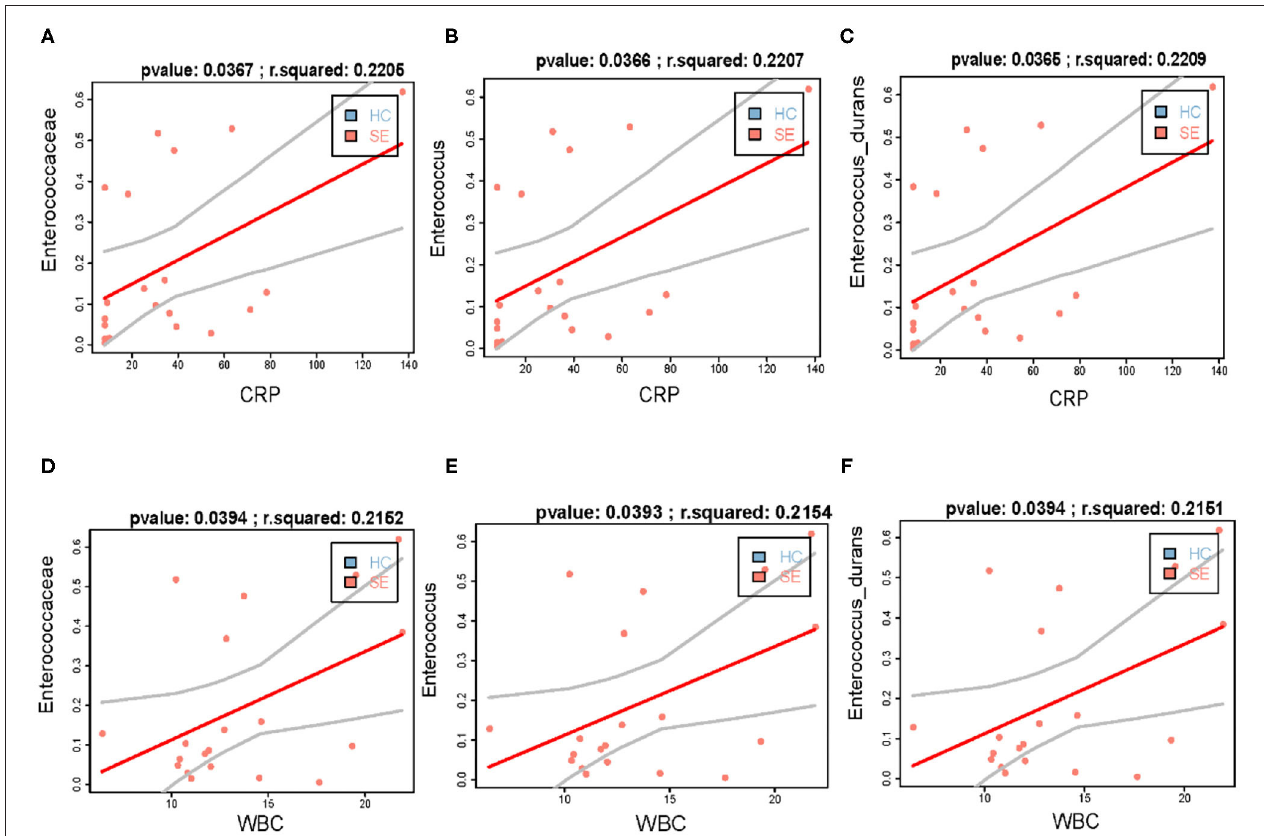
FIGURE 2 | The increase in the abundance of Enterococcaceae bacteria in gut of patients with sepsis is positively correlated with the increase in blood indicators WBC and CRP. (A–C) the increased abundance of gut Enterococcaceae (A) , Enterococcus (B) , and Enterococcus durans (C) is positively correlated with WBC, respectively; (D–F) the increased abundance of gut Enterococcaceae (D) , Enterococcus (E) , and Enterococcus durans (F) is positively correlated with CRP,